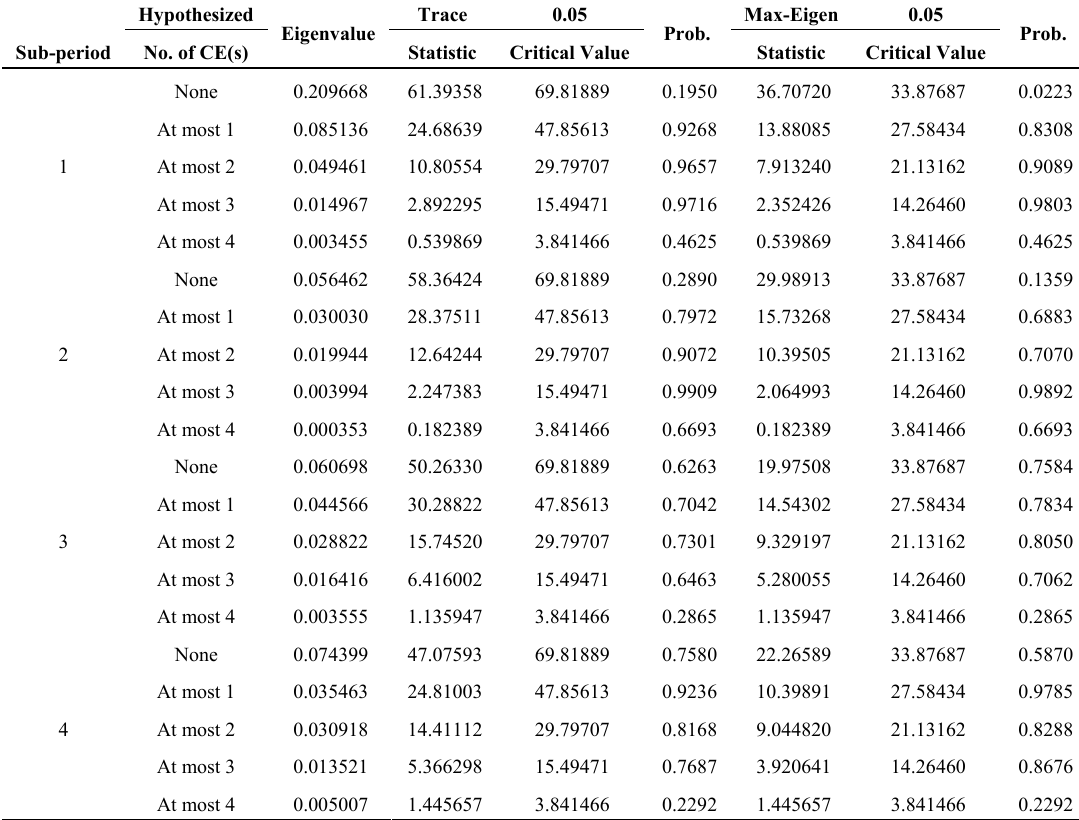
Table A12. Test for Possible Regional Cointegration in Asia.